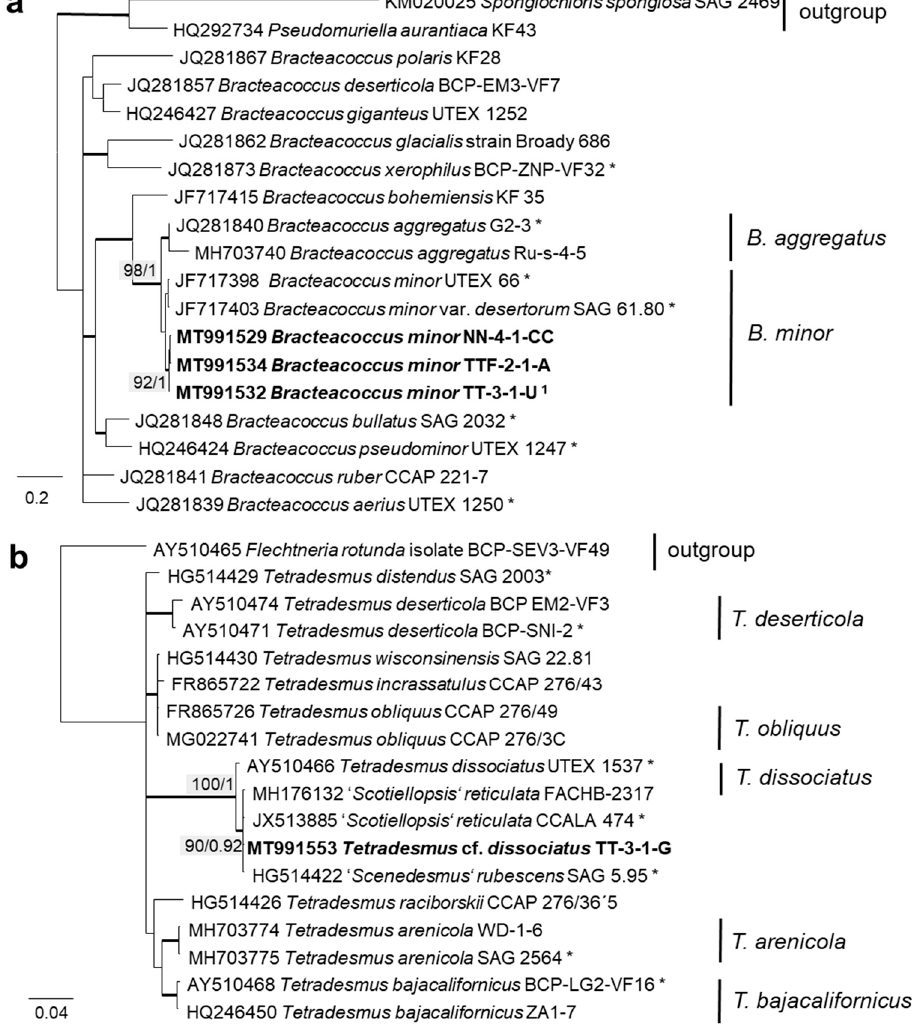
Figure 7. Molecular phylogeny of Sphaeropleales genera based on ITS-1,2 sequencing. ( a ) Bracteacoccus (only ITS-2) and ( b ) Tetradesmus . The phylogenetic tree was calculated by the Bayesian method, including posterior probabilities (PP) with additional maximum likelihood bootstrap values (BP); branches are supported by both methods in bold (BP > 60% and PP > 0.9). Authentic strains marked with an asterisk, original strains from this study in bold. 1 Identical to Bracteacoccus minor TTF-1-1-M (MT991533), TTF-2-1-J (MT991535), TT-3-1-J (MT991531), NN-4-1-D2 (MT968390), and NN-4-1-H (MT991530).